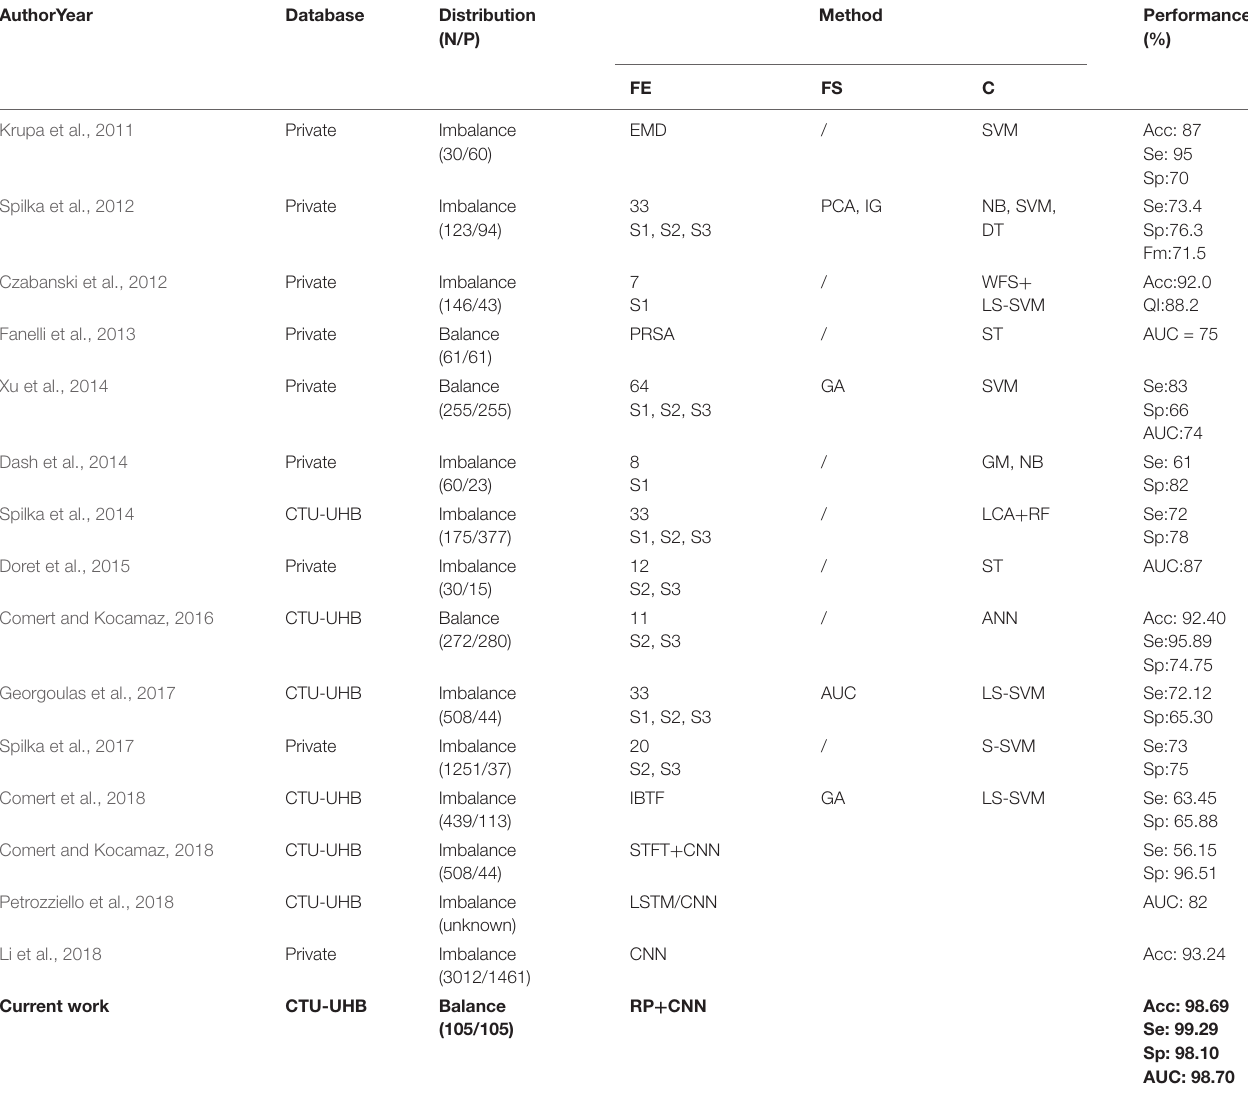
TABLE 5 | Summary of related works aimed at the prediction of the fetal state using fetal heart rate (FHR) signals obtained from cardiotocography